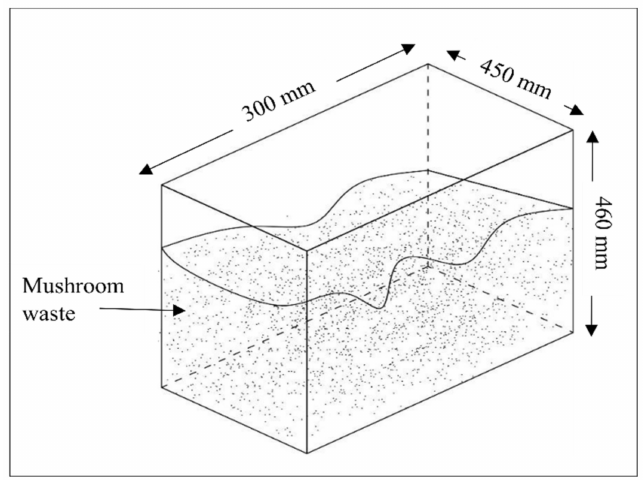
Figure 1. Illustrated diagram of a rectangular glass jar.